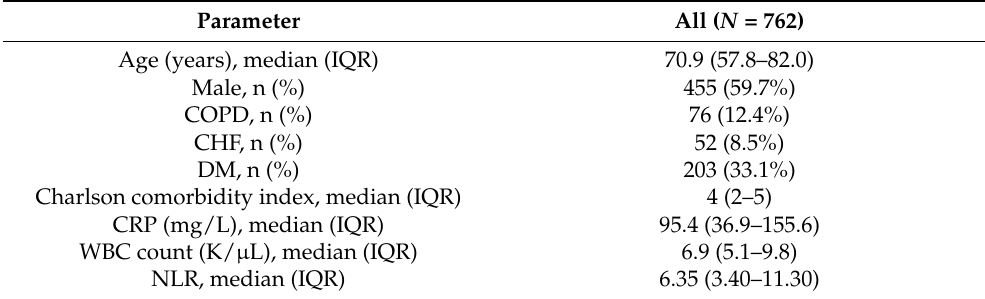
Table 1. Patient’s